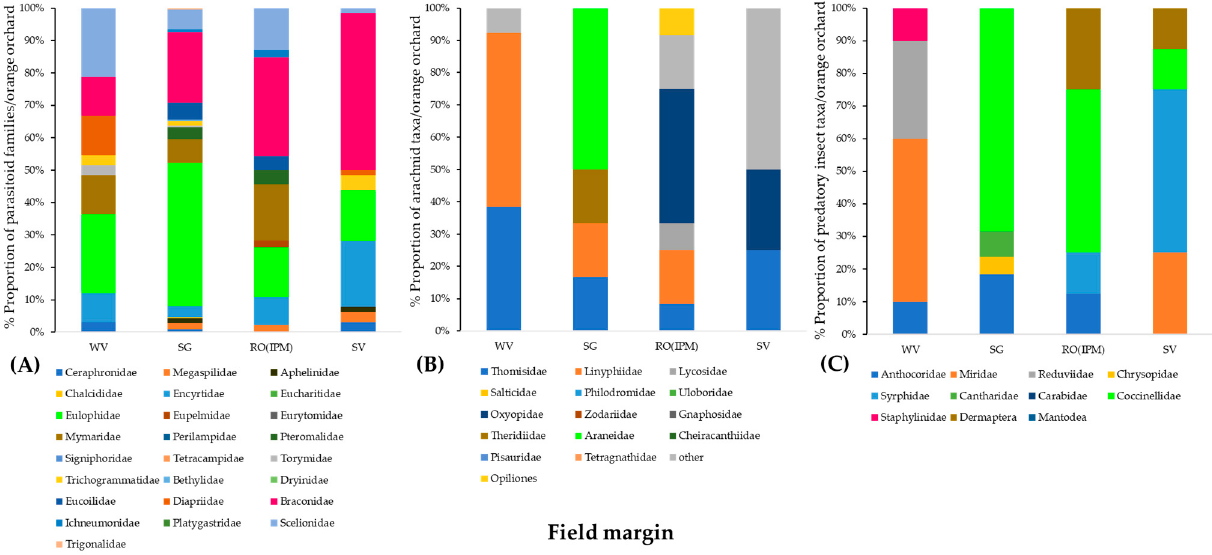
Figure 3. Community composition of ( A ) Hymenoptera parasitoids, ( B ) arachnid predators, and ( C ) insect predators in four orange orchards (WV, SG, SV, and RO(IPM)) at the baseline year (field margin management using the usual farmers’